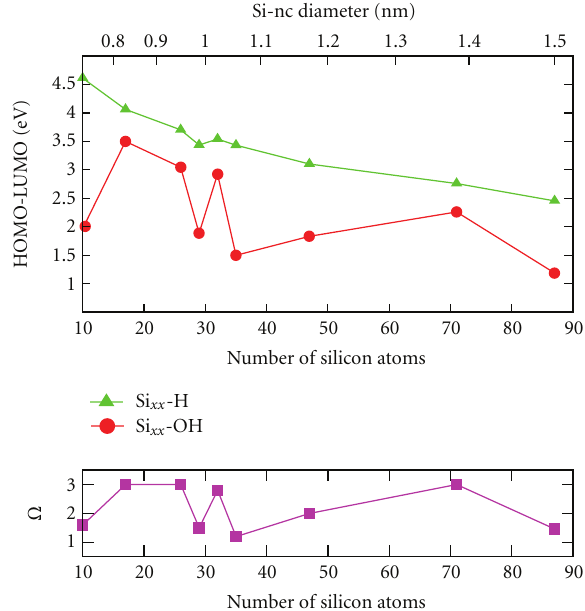
Figure 3: HOMO-LUMO gaps for the hydrogenated (triangles) and hydroxided (circle) nanocrystals together with the oxidation degree Ω (squares) as function of the Si-nc diameter